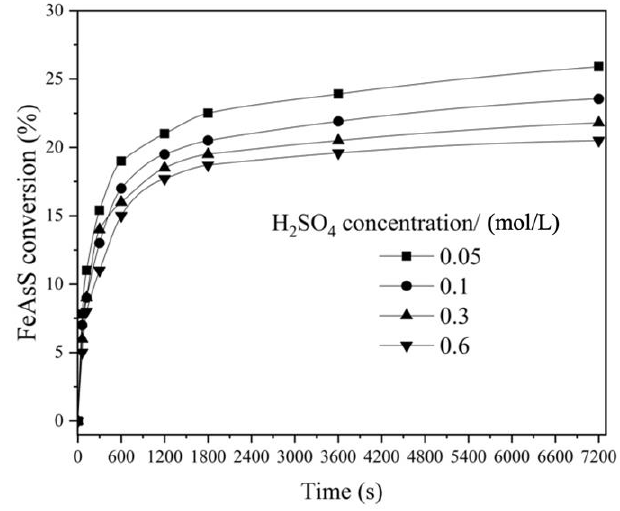
Figure 5. Effect of H 2 SO 4 concentration on hydrothermal conversion of FeAsS (100 rpm; 503 K; 0.16 mol/L of Cu; 10 –29 μm). 0.16 mol/L of Cu; 10–29 µ